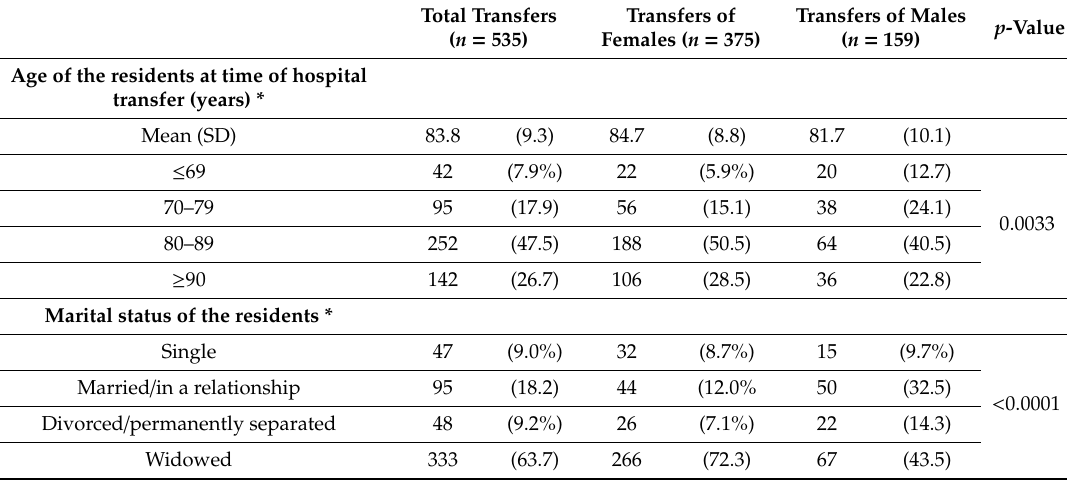
Table 1. Characteristics of unplanned transferred nursing home residents. Total Transfers ( n =